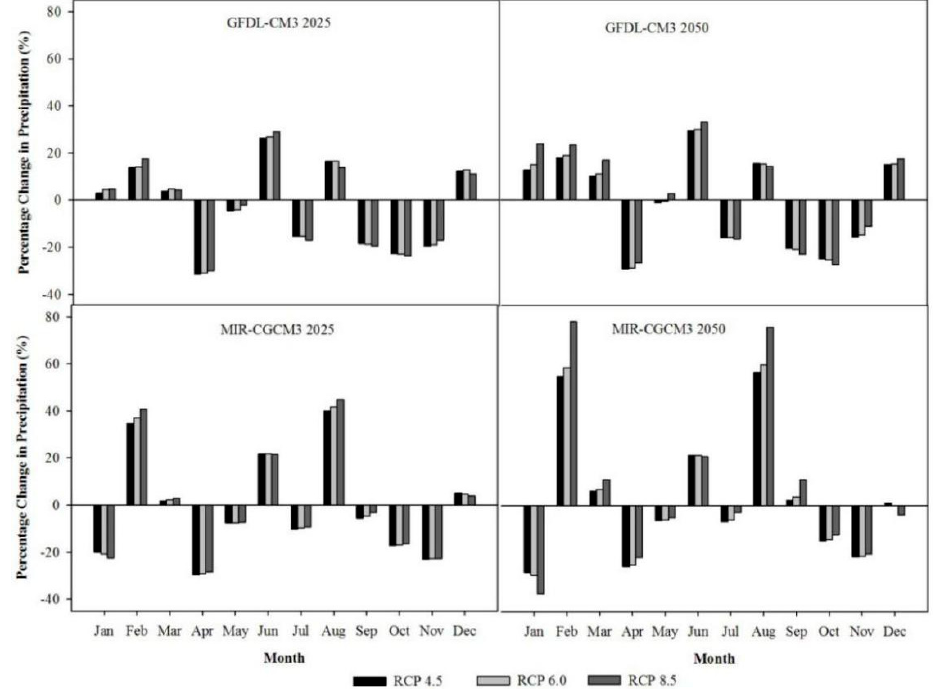
Figure 3. Changes in precipitation (%) as projected for 2025 and 2050 based on three RCPs for two GCMs compared with 1961–1990 for Guanzhong Plain.